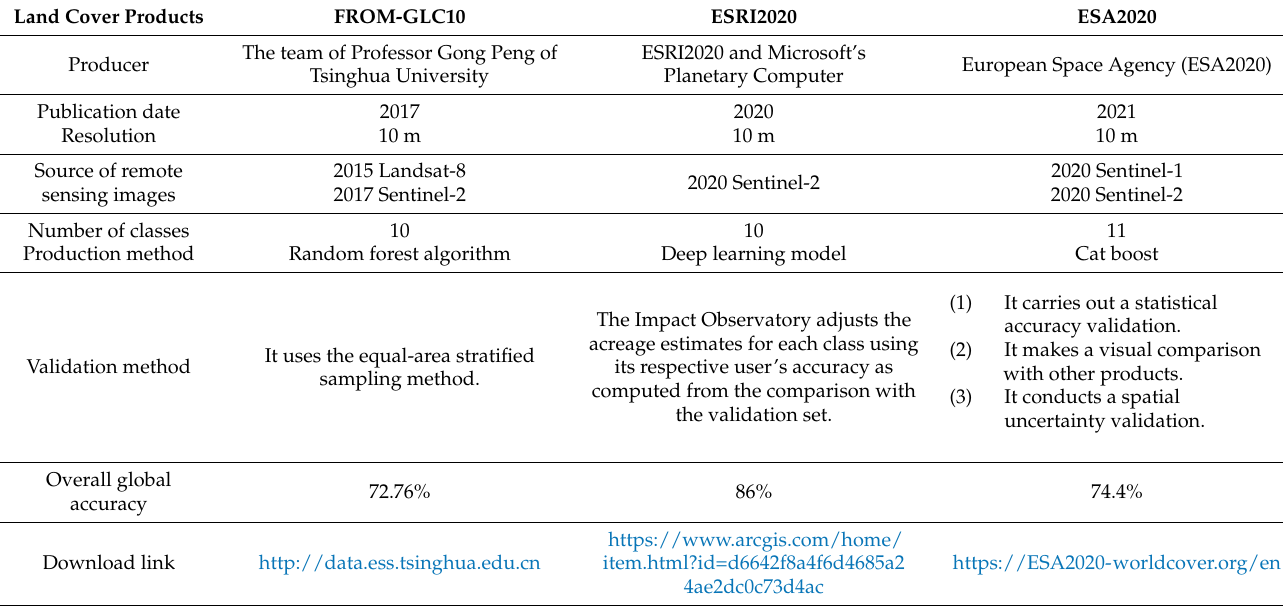
Table 1. Comparison of the three land cover